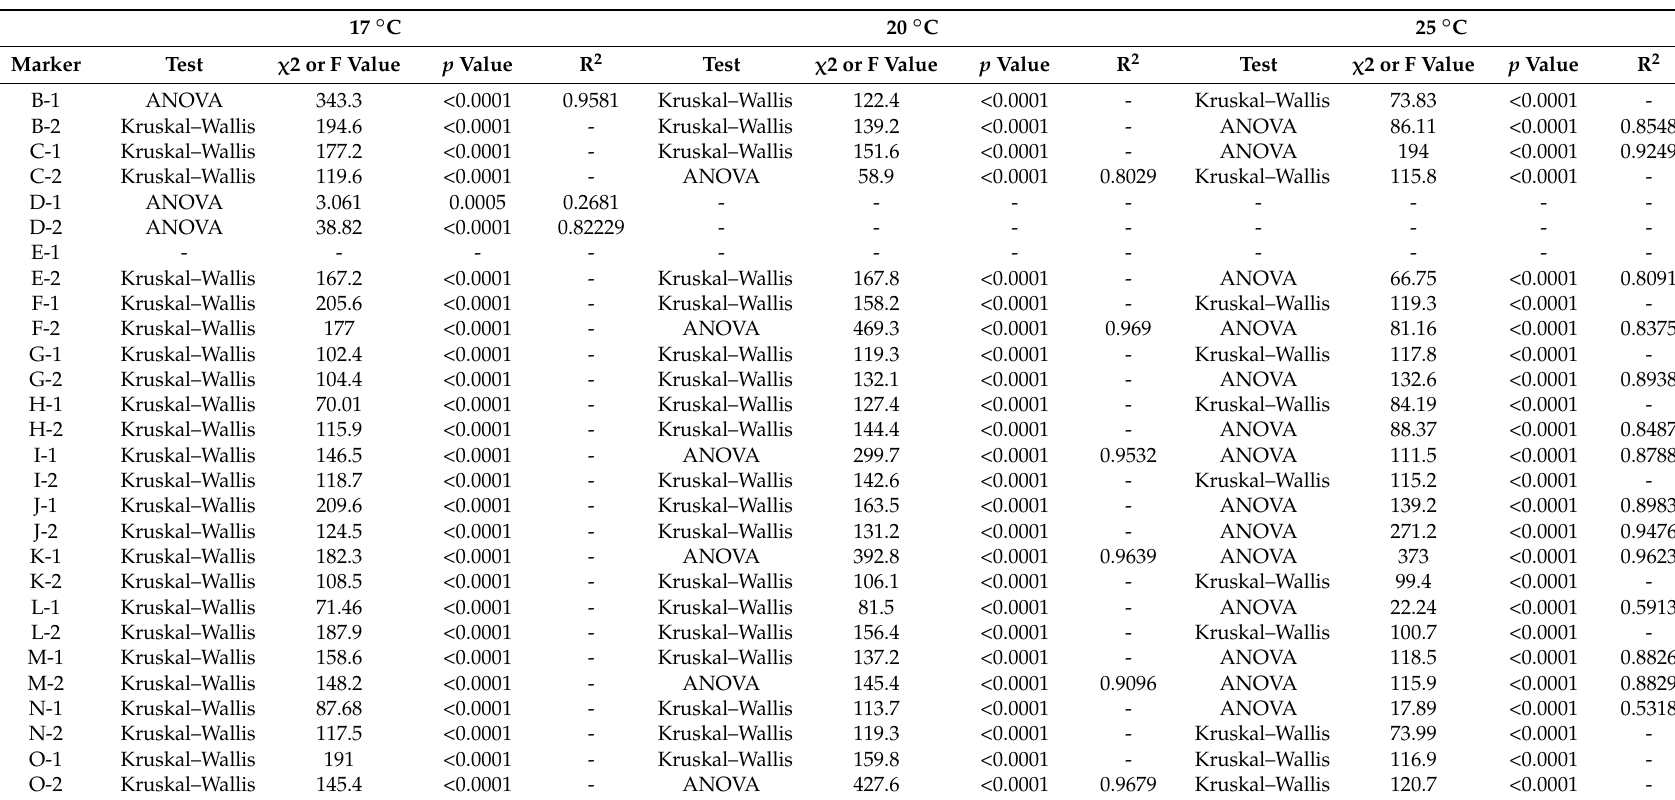
Table 4. One-way analysis of variance (ANOVA) and the Kruskal–Wallis test for changes in gene expression during metamorphosis. Markers D1 and D2 showed negligible change of gene expression at 17 ◦ C and were not analysed at 20 ◦ C and 25 ◦ C. Marker E1 qPCR assay failed to detect gene